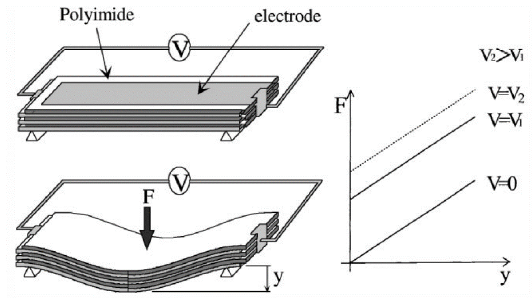
Figure 1. Electro-bonded laminate working principle [31].